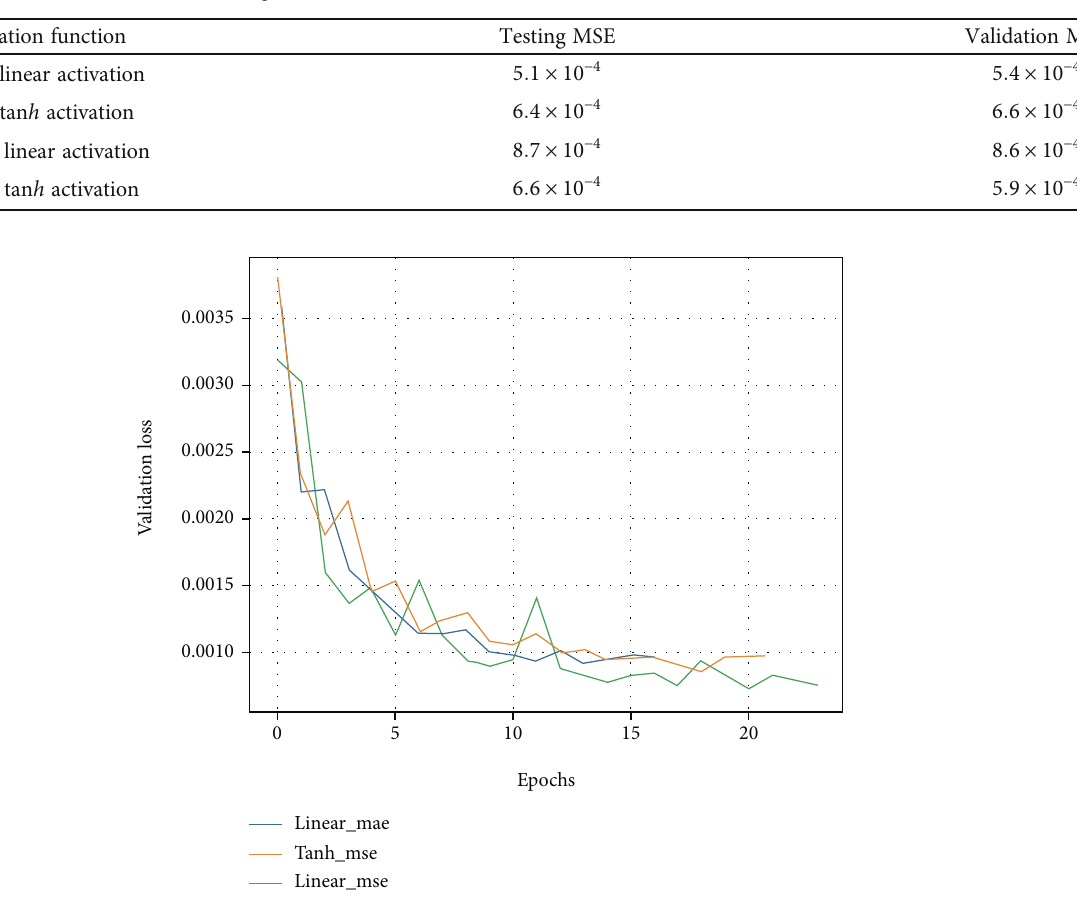
Figure 8: Validation loss for models trained with and without ROI Table 2: Testing and validation loss under di ff erent loss and activation functions.